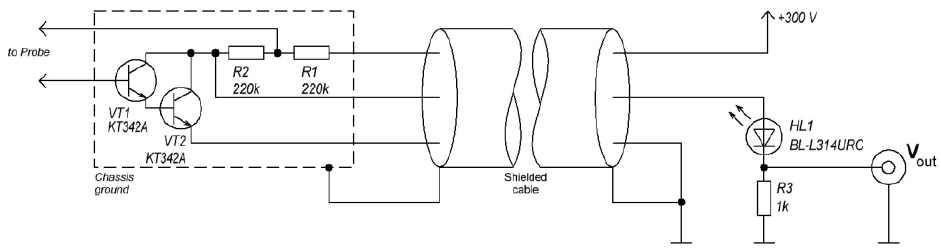
Figure 8. Electrical circuit of an active twin ion